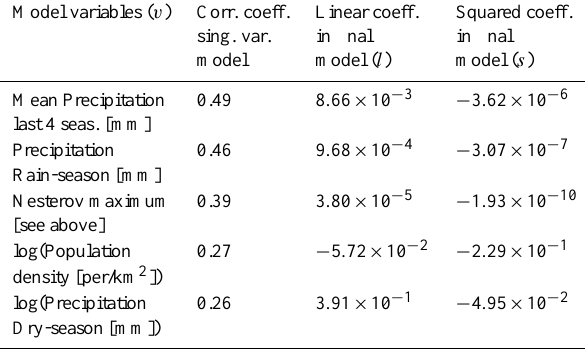
Table A1. Parameterisation of model C. Correlation coefficient (R- value) of all single variable models and linear and squared coeffi- cients for model C. The constant term for the final model is − 7.91. The abbreviations v , l and s are used in Eq. (A1). Model variables ( v ) Corr. coeff. Linear coeff. Squared coeff. sing. var. in final in final model model ( l ) model ( s ) 0.49 8 . 66 × 10 −